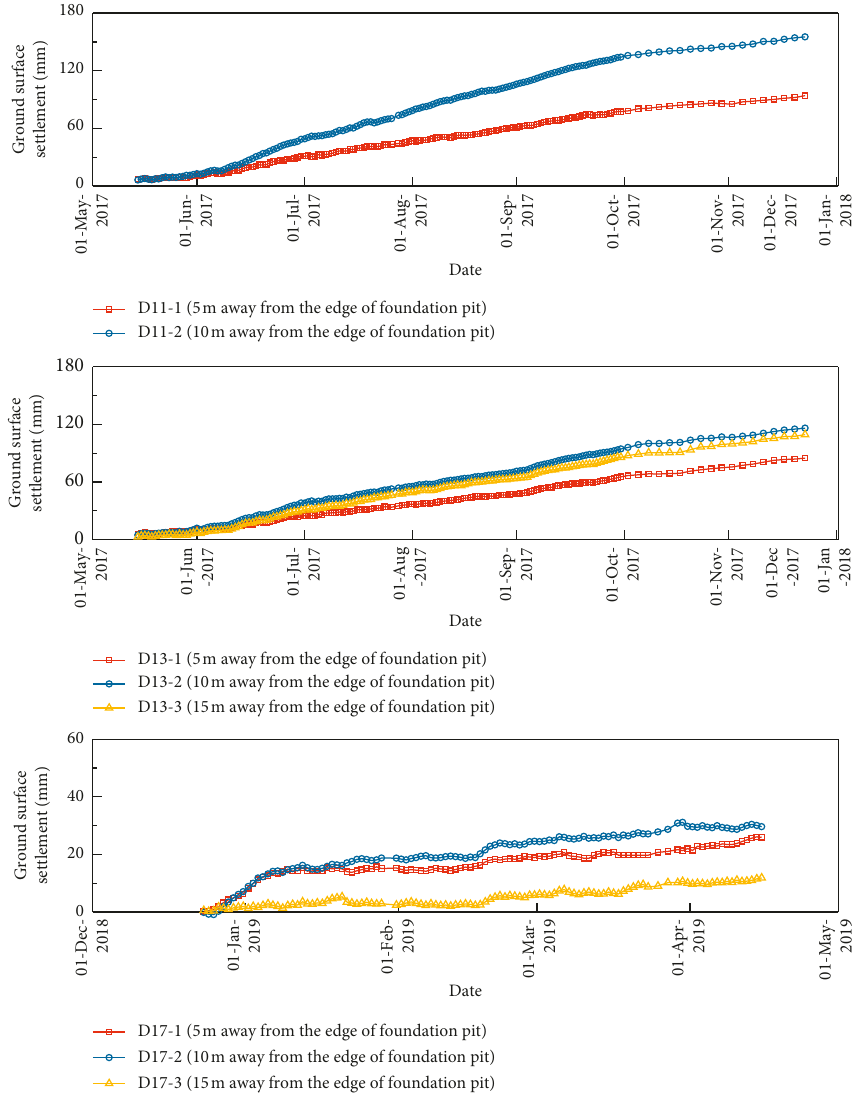
Figure 13: Curve of the measured ground surface settlement with respect to